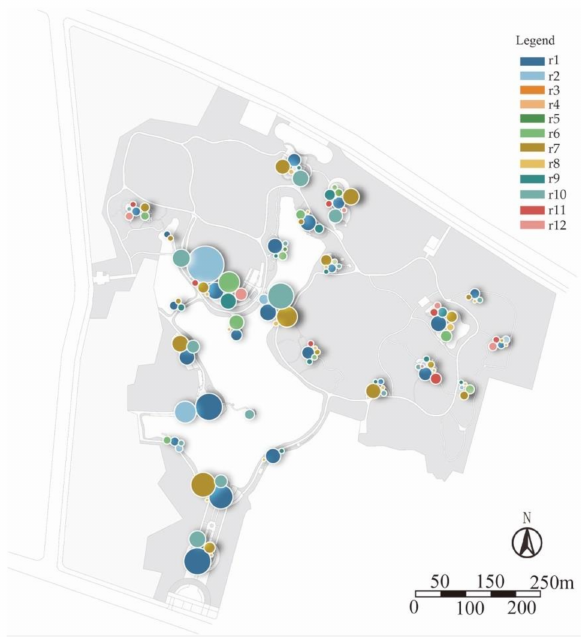
Figure A9. Spatial distribution of various recreational activity users in Tianhe Park.